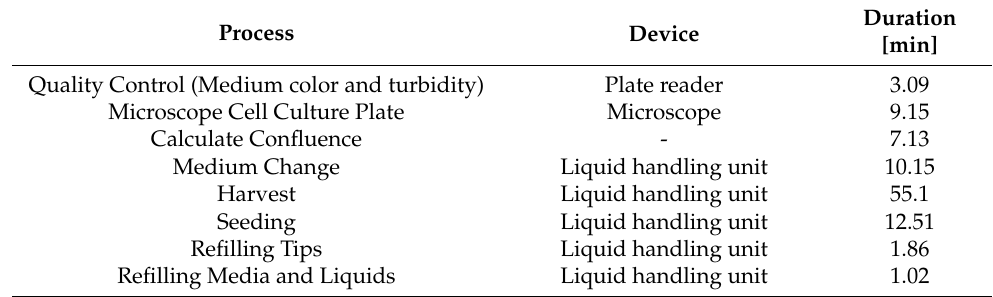
Table 2. Process durations for the individual process step simulations, estimated from process